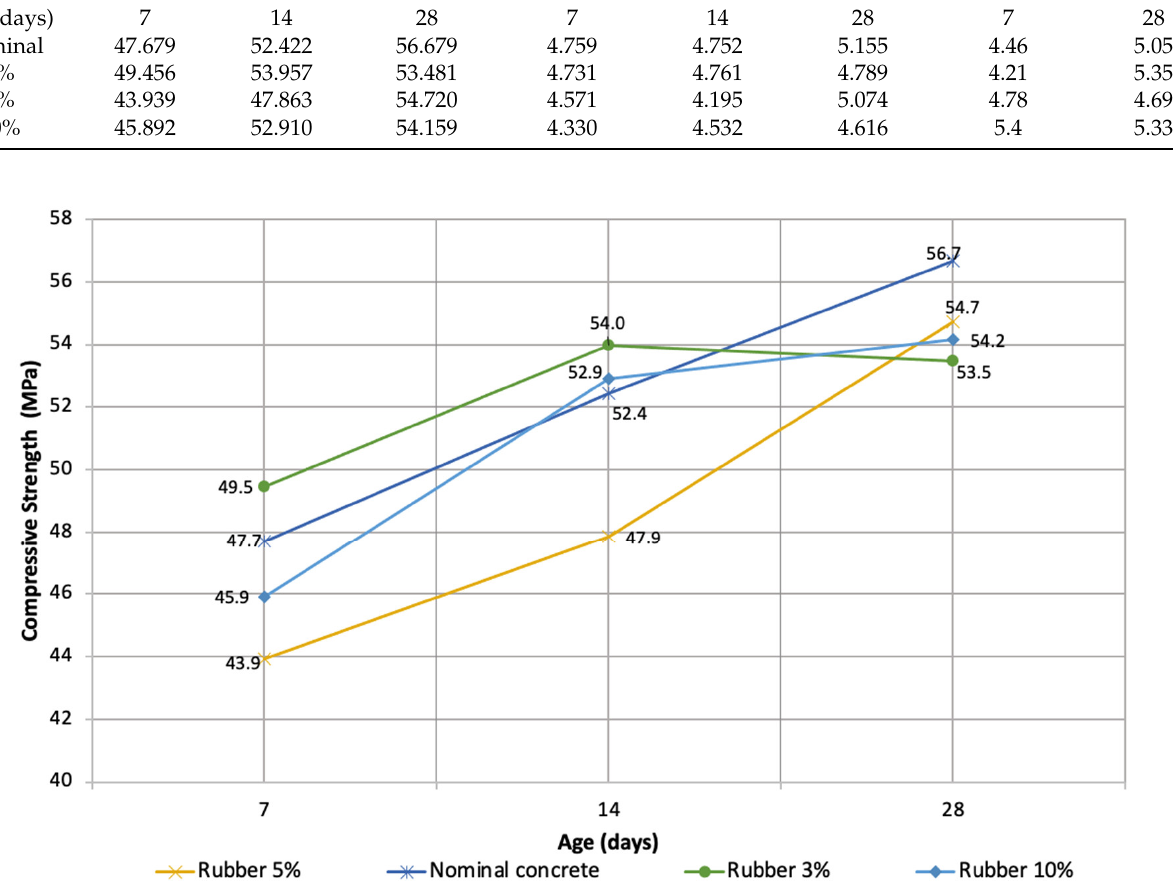
Table 4. Mechanical properties through destructive testing.